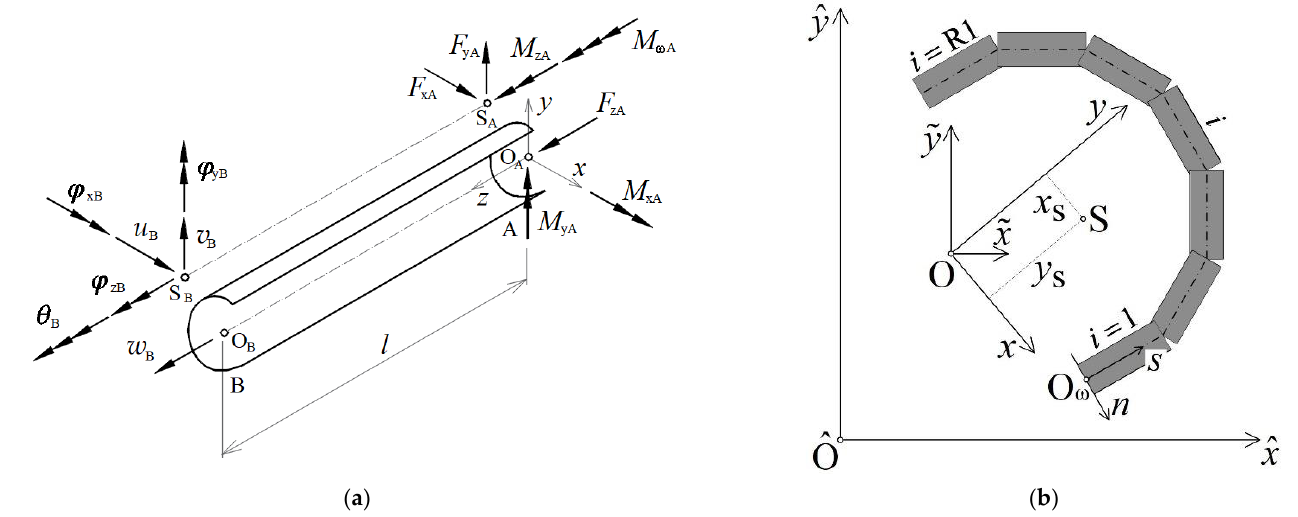
Figure 1. Beam model: ( a ) thin-walled beam element and ( b ) approximated cross-section geome- try.